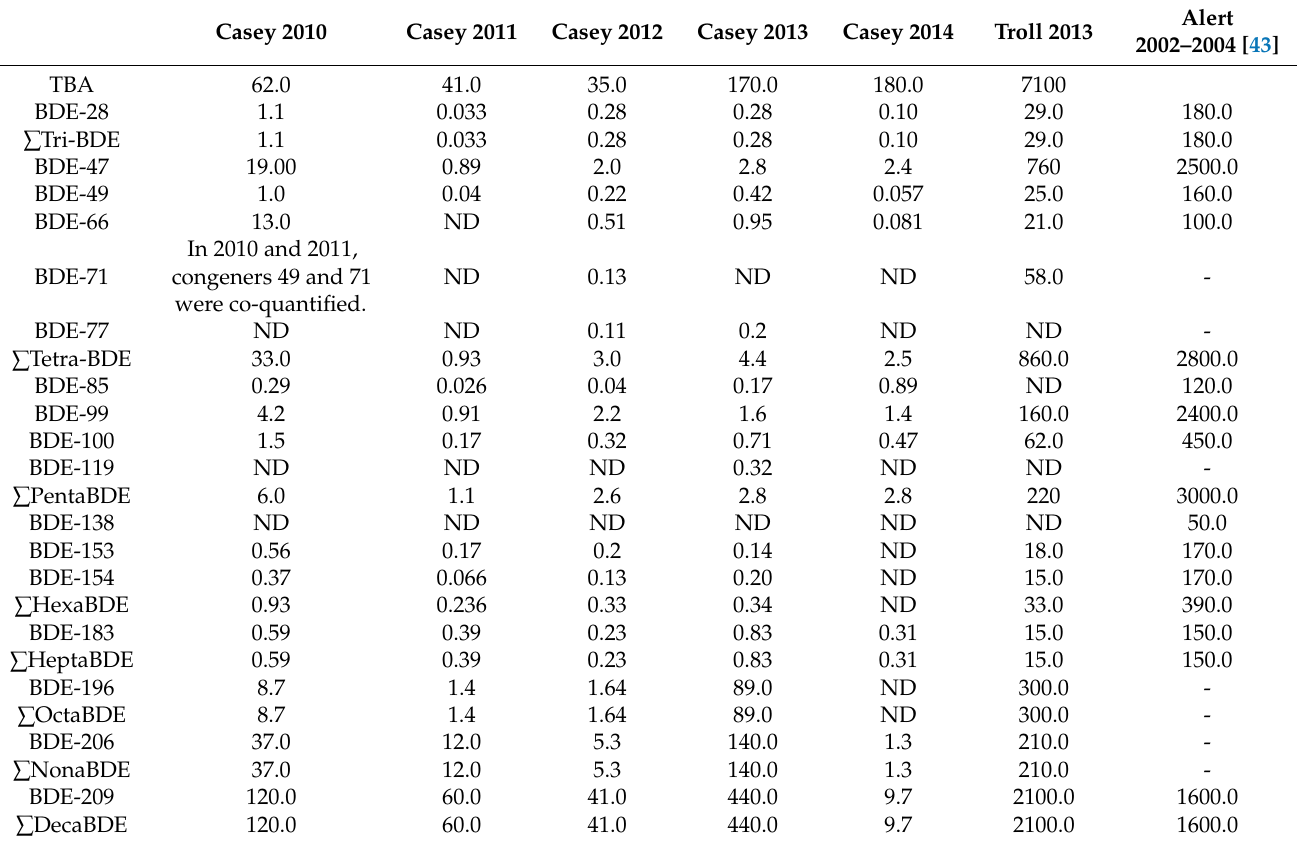
Table 2. Annual average brominated compound concentrations (fg/m 3 ) at Casey and Troll Stations, presented alongside recent measurements from the Arctic. Casey and Troll station annual mean concentrations were obtained only from samples >LOQ. Non-detect (ND) denotes concentrations < LOQ and “-” denotes an analyte not